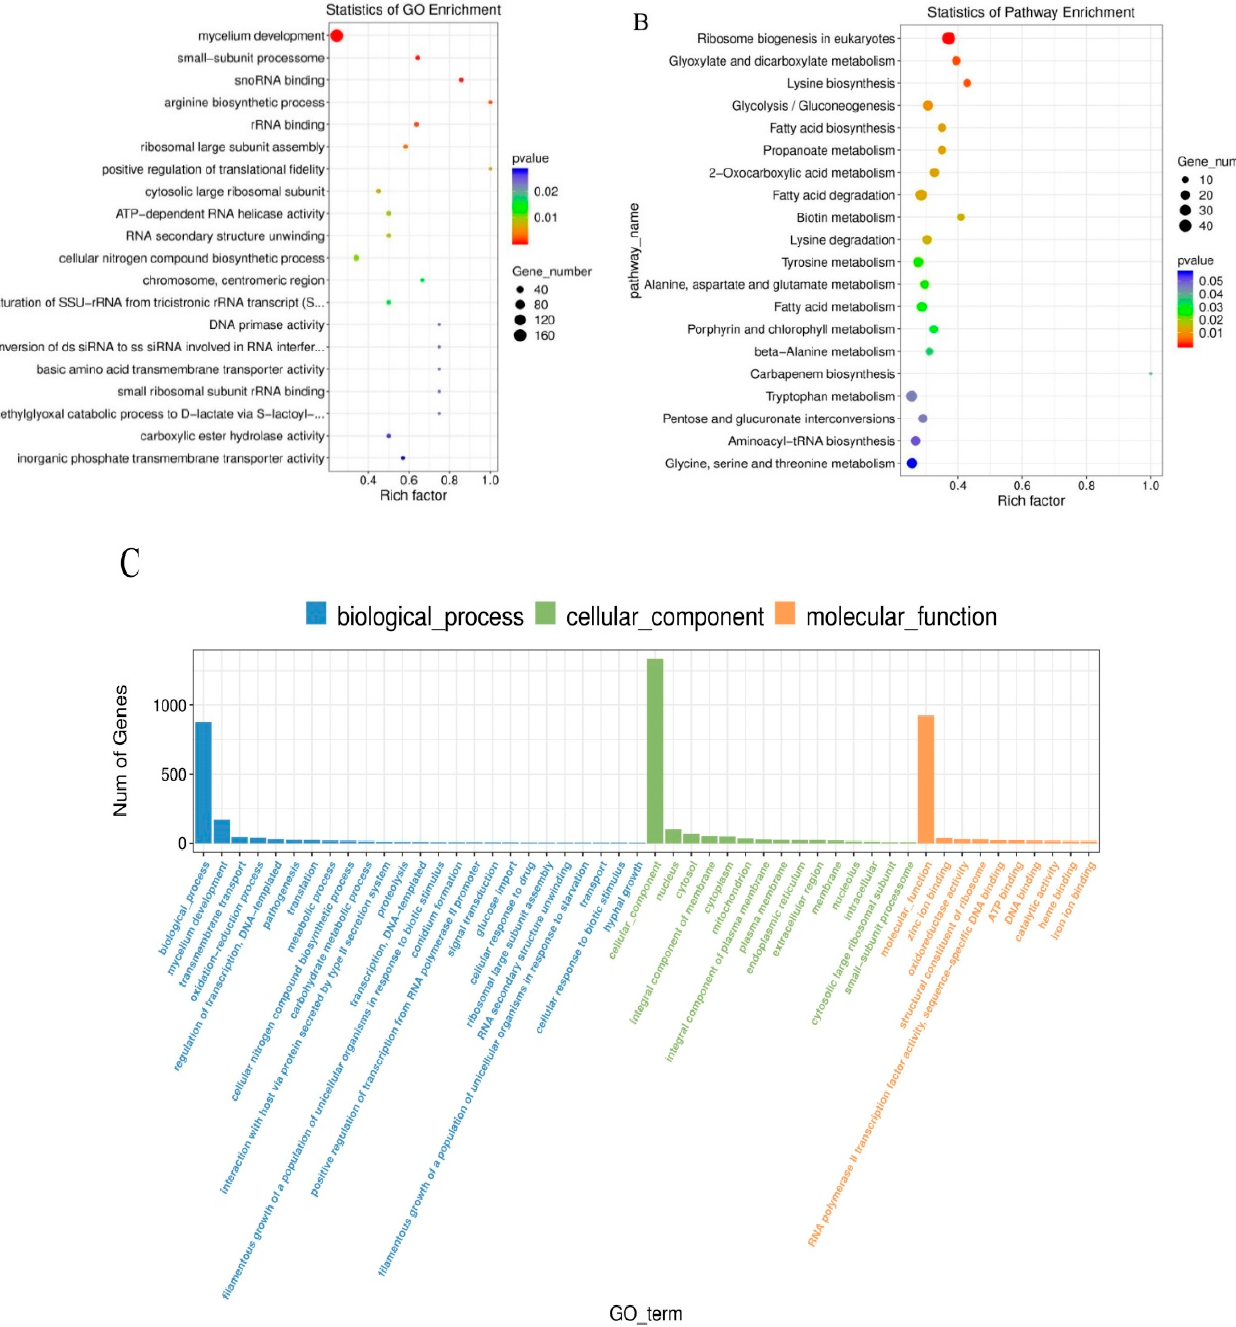
Figure 4. Summary of the annotations of DEGs in M. oryzae . ( A ) GO classifications. ( B ) Scatter plot of KEGG enrichment of DEGs. ( C ) Enrichment of GO genes in M. oryzae after treatment with citral (100 µ g/mL) for 24 h.